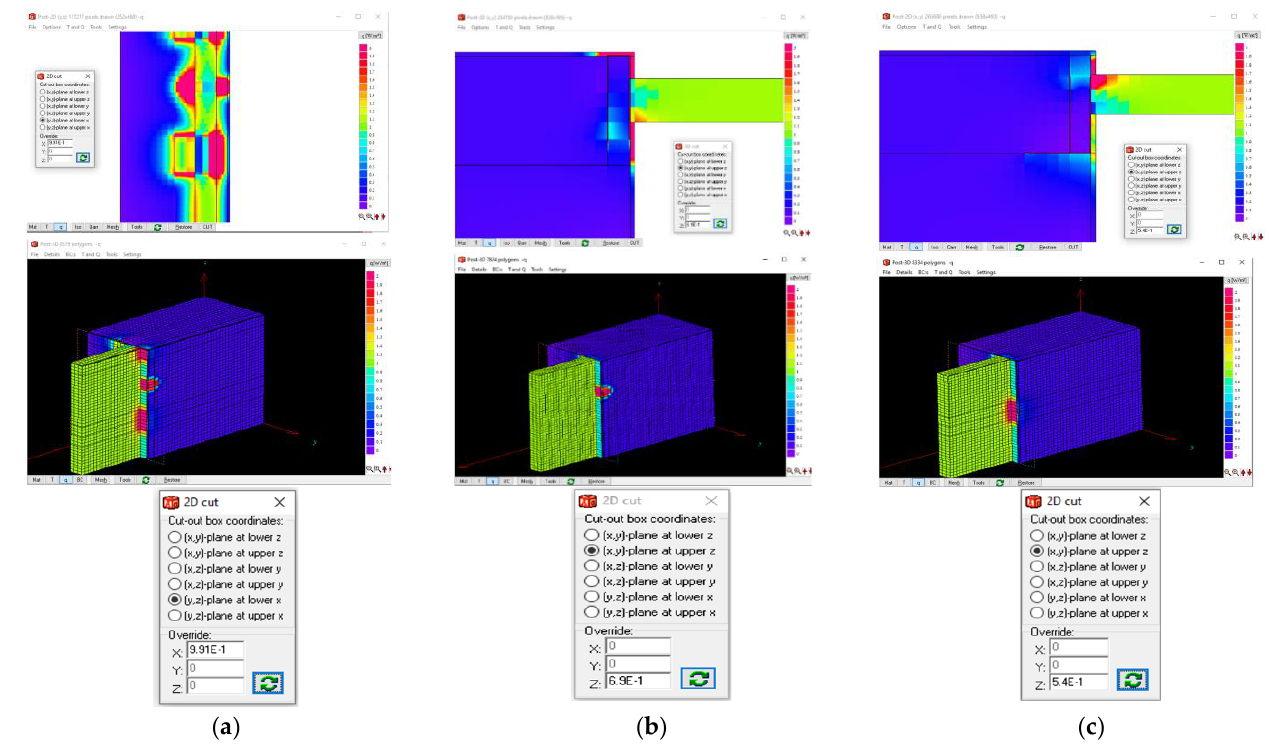
Figure 11. Intensity of heat flows in the cross-section of fasteners: ( a ) set of fasteners: corner fastener CL, interconnect fastener EL, and window frame fastener W; ( b ) separate W fastener; ( c ) separate EL fastener.